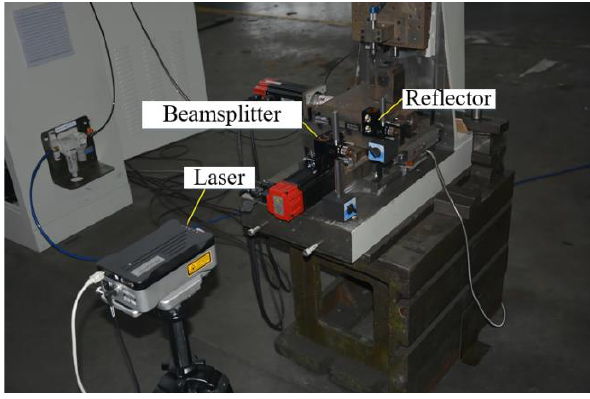
Figure 19. XL-80 laser interferometer.